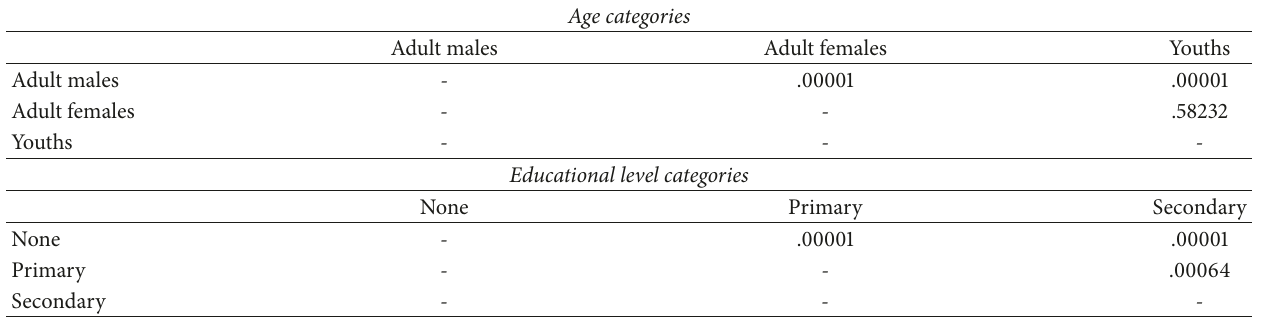
Table 1: P-value matrix for cross tabulation of sex, age group, and educational level categories of respondents.